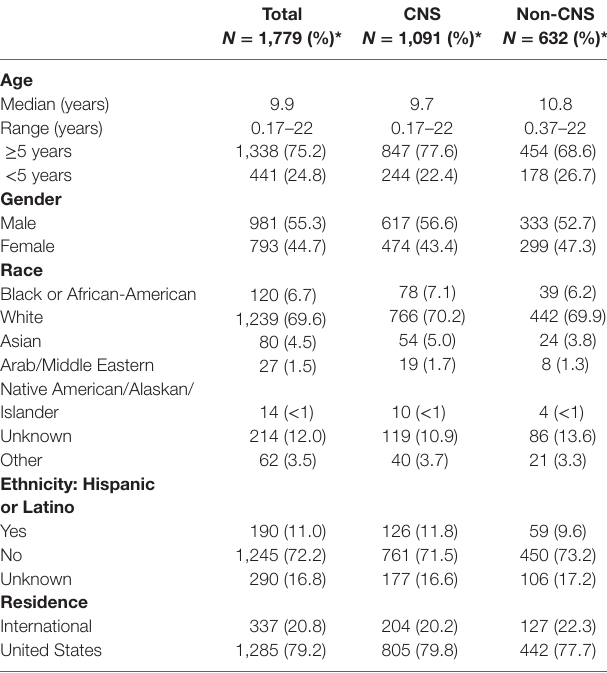
TaBle 2 | Pediatric Proton Consortium Registry patient